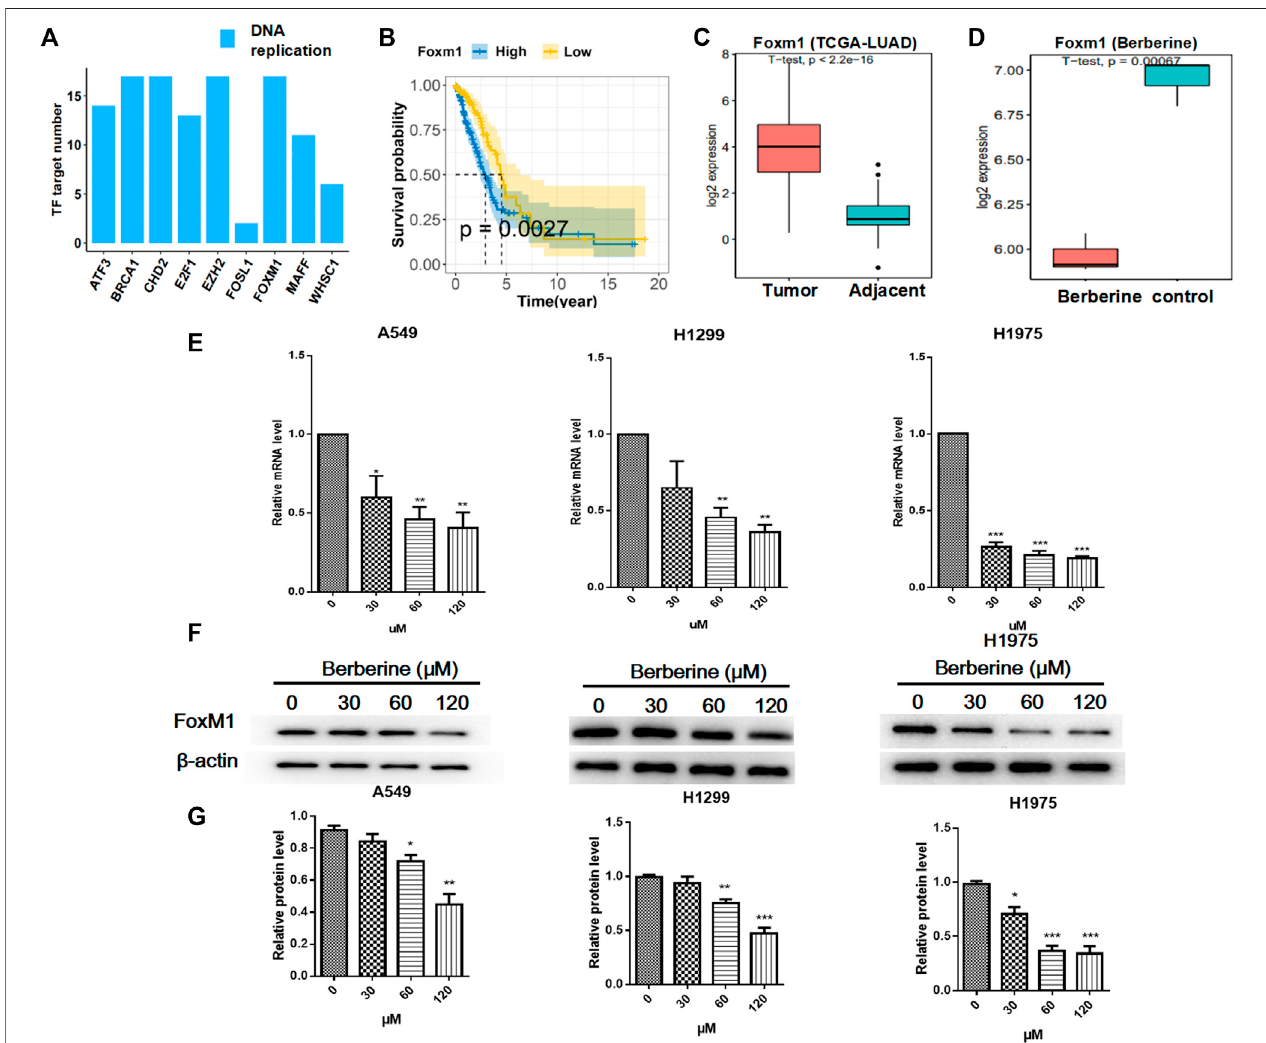
FIGURE 3 | Berberine down regulated the expression of FOXM1 related to survival. (A) Number of target gene regulated by TF or TF cofactors. These target gene were DNA replication pathway related differential genes. (B) Survival analysis ofoverall survival in FOXM1 high and low expressed (cutted by median expression) groups of patients of TCGA-LUAD Cohort. p value from Kaplan-Meier analysis. (C,D) Boxplot of the expression level of FOXM1 in TCGA-LUAD cohort and berberine treatment cohort. p value from student t-test. (E) Berberine down-regulated FOXM1 mRNA levels in both A549, H1299 and H1975 cells. (F) Berberine down-regulated FOXM1 expression by WB in both A549, H1299 and H1975 cells. (G) Data were pooled from three independent experiments. * p < 0.05; ** p < 0.01; *** p < 0.001, compared with the control group.